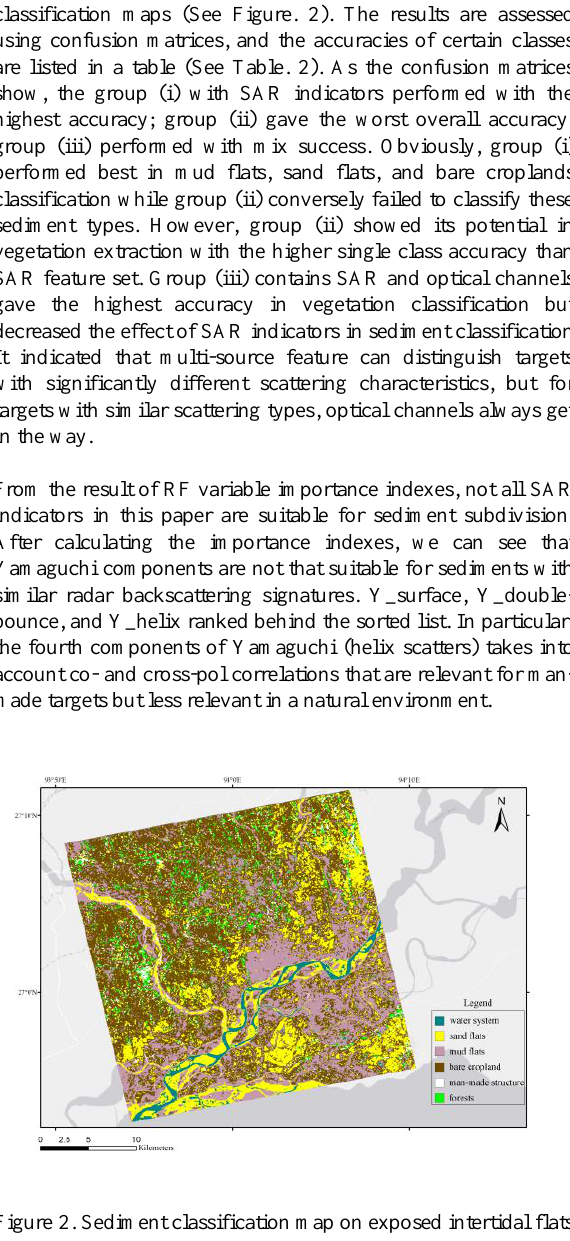
Figure 2. Sediment classification map on exposed intertidal flats using RF classifier based on full-polarimetric SAR features